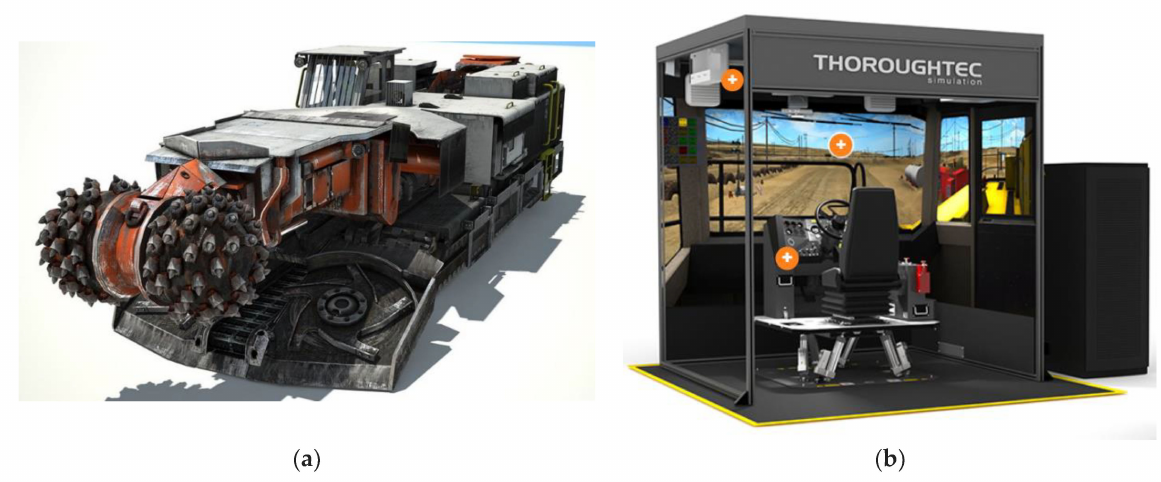
Figure 2. The roadheader IBS SM130 Simulator by Immersive Technologies (IM360-B Training Simulator) [1]: ( a ) roadheader view, ( b ) simulator stand.